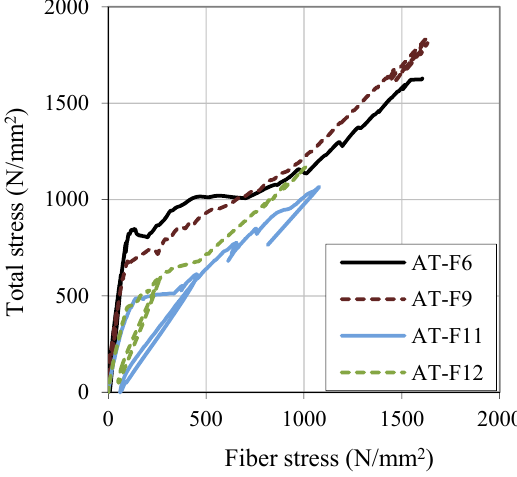
) in Series AT-F. Fiber